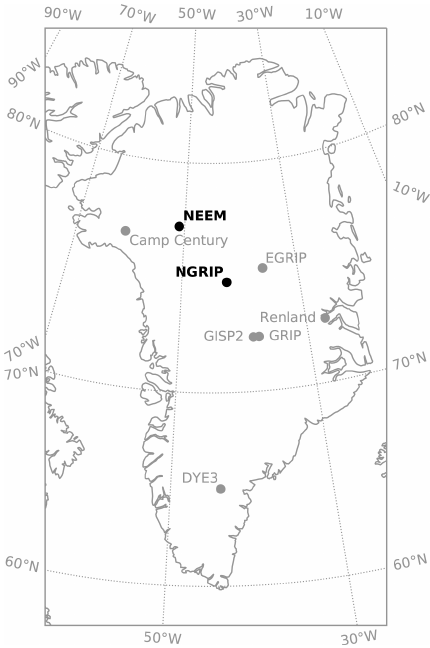
Figure 2. Locations of deep Greenland ice cores with the loca- tions of NGRIP and NEEM highlighted in bold. The drill loca- tion of NGRIP is located at 75.10 ◦ N, 42.32 ◦ W, 2921ma.s.l., that of NEEM at 75.45 ◦ N, 51.06 ◦ W, 2450ma.s.l. (Dahl-Jensen et al., 2002; NEEM community members,